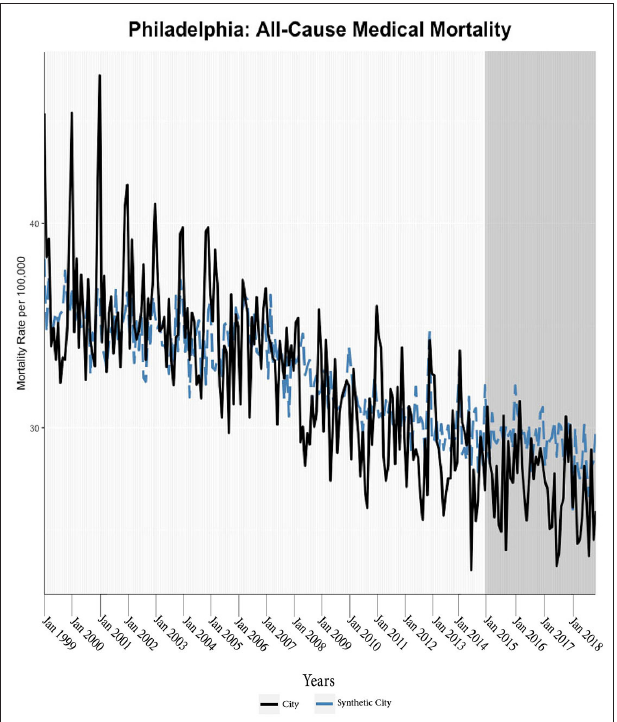
FIGURE 5 | All-cause mortality trends: Boston and synthetic control city.